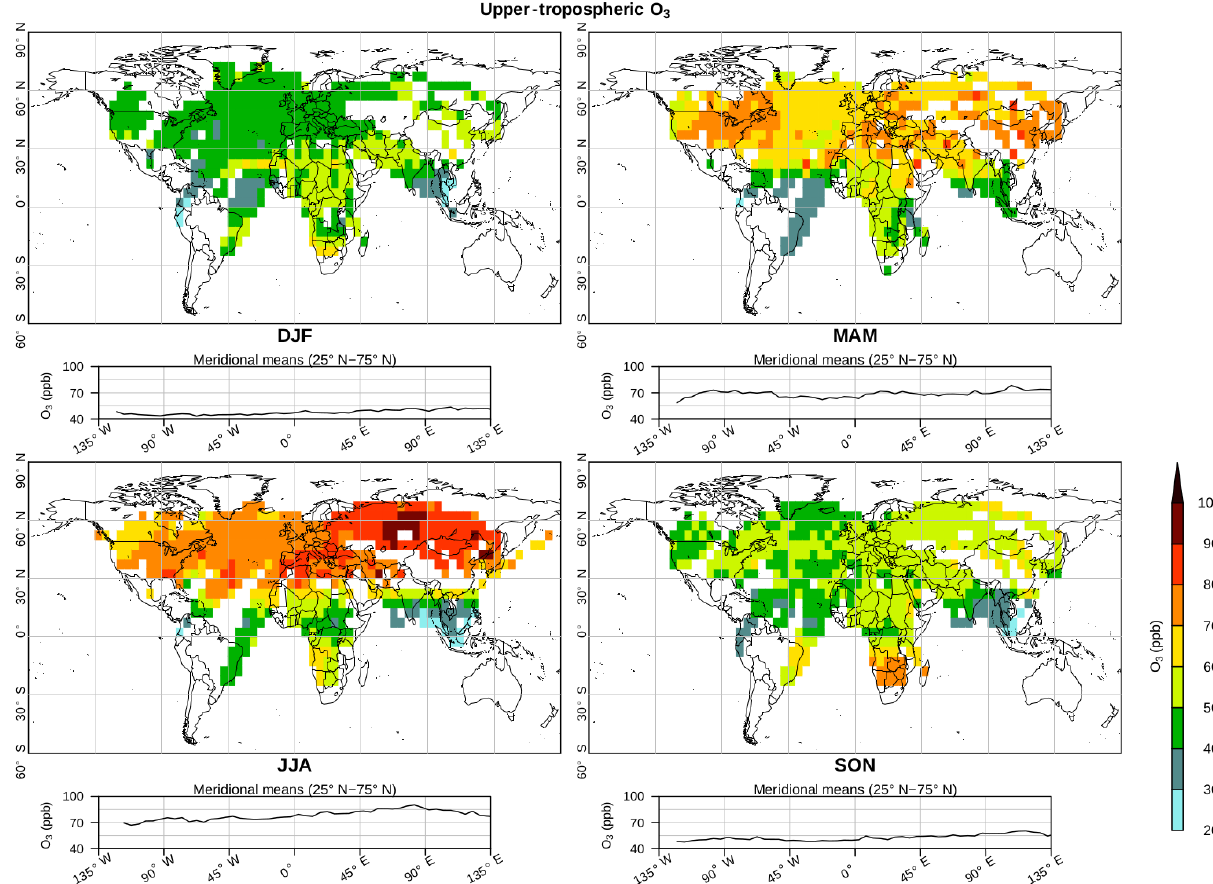
Figure 3. Horizontal distributions of O 3 volume mixing ratios in the UT averaged from December 1994 to November 2013, in every season. Each 2-D distribution is projected onto the zonal axis below, with a meridional average of the northern extratropical zonal band (from 25 to 75 ◦ N). The 2-D (1-D) distributions have a 5 ◦ × 5 ◦ (5 ◦ ) resolution. The x axes are the same in the maps and in the projections